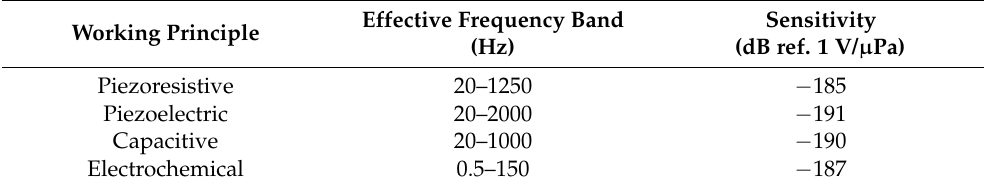
Table 2. The effective frequency bands and sensitivities of co-oscillating vector hydrophones based on different working